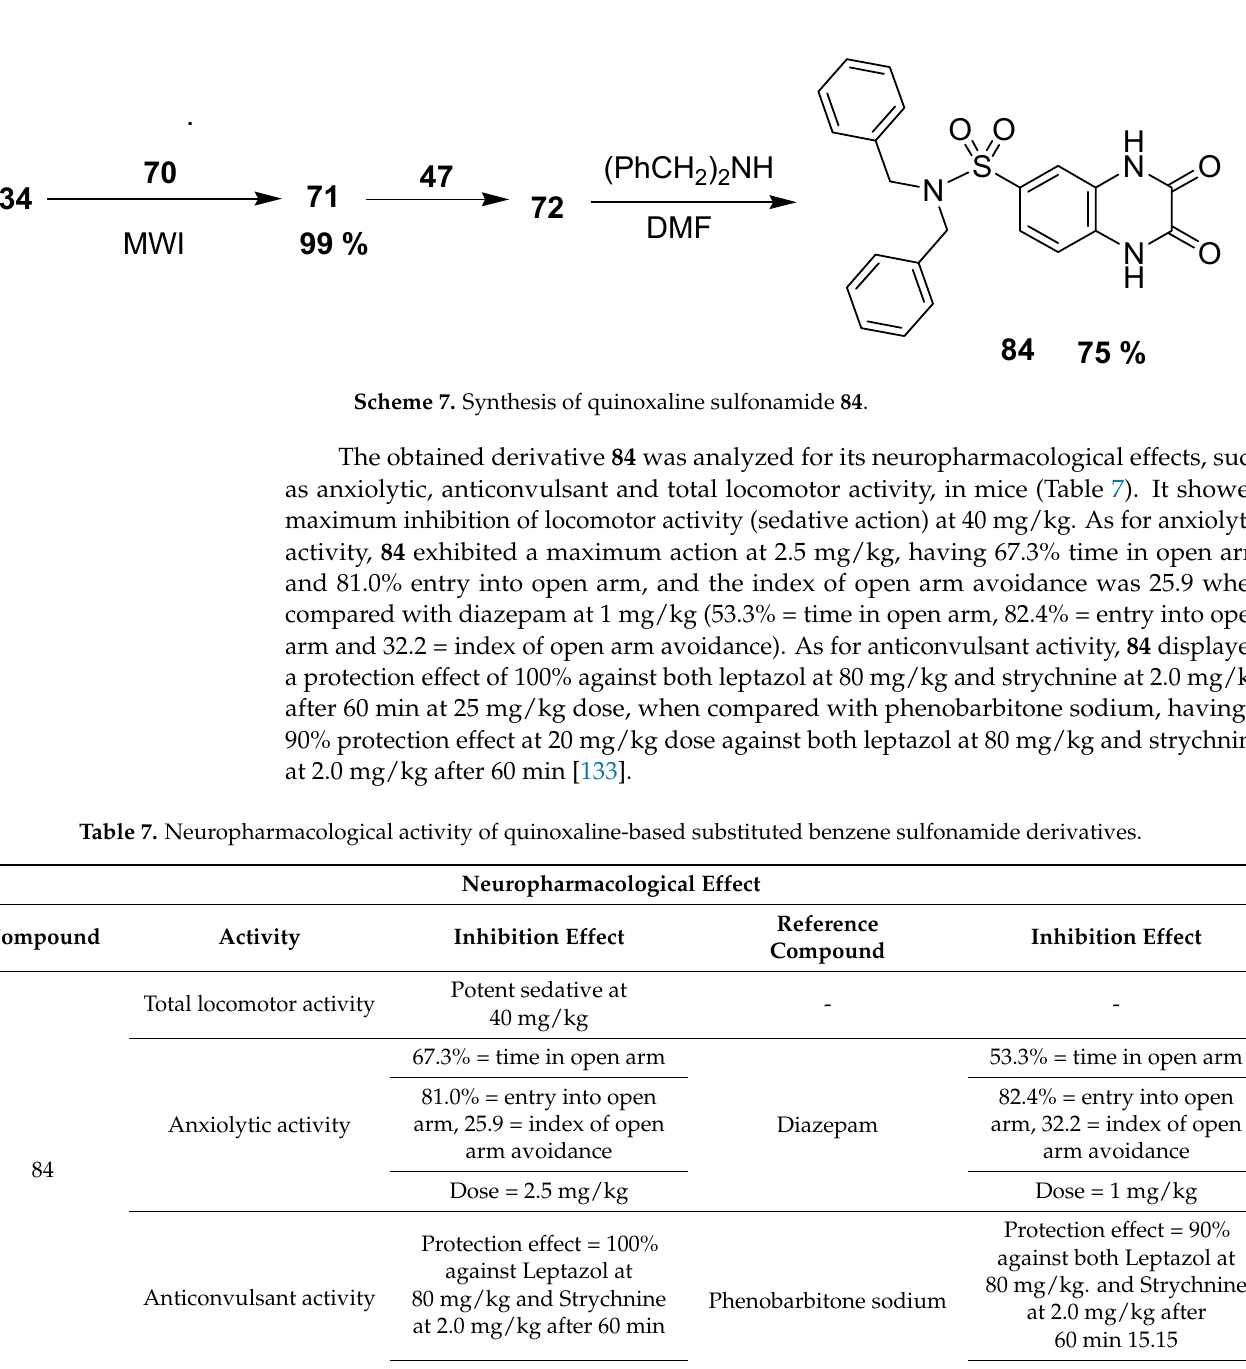
83 Figure 12. Substituted quinaxoline sulfonamide derivatives 81–83 . Table 6. Antimicrobial activity of quinoxaline derivatives 81–83 . Antimicrobial Activity Compound